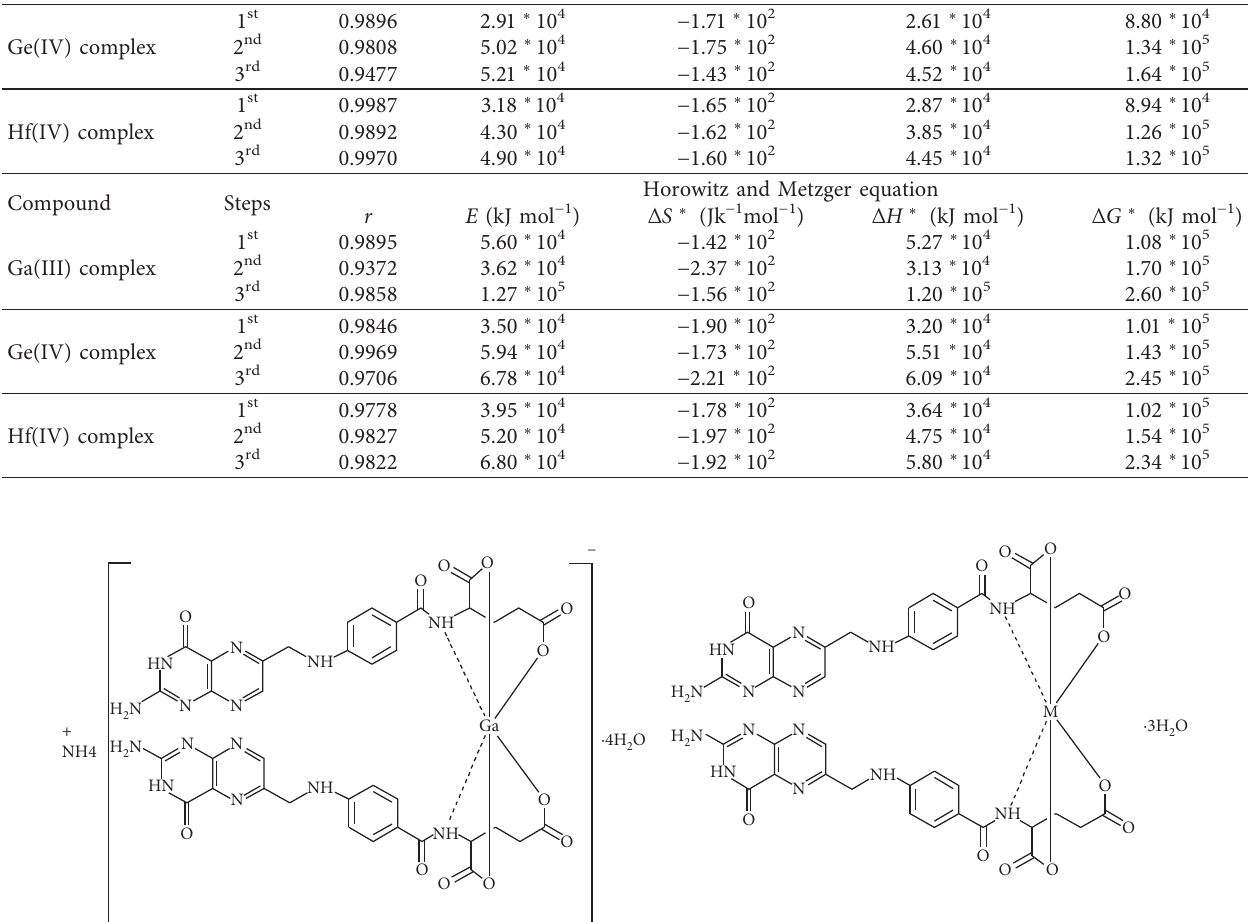
Table 5: Kinetic thermodynamic parameters of the FAH Compound Steps